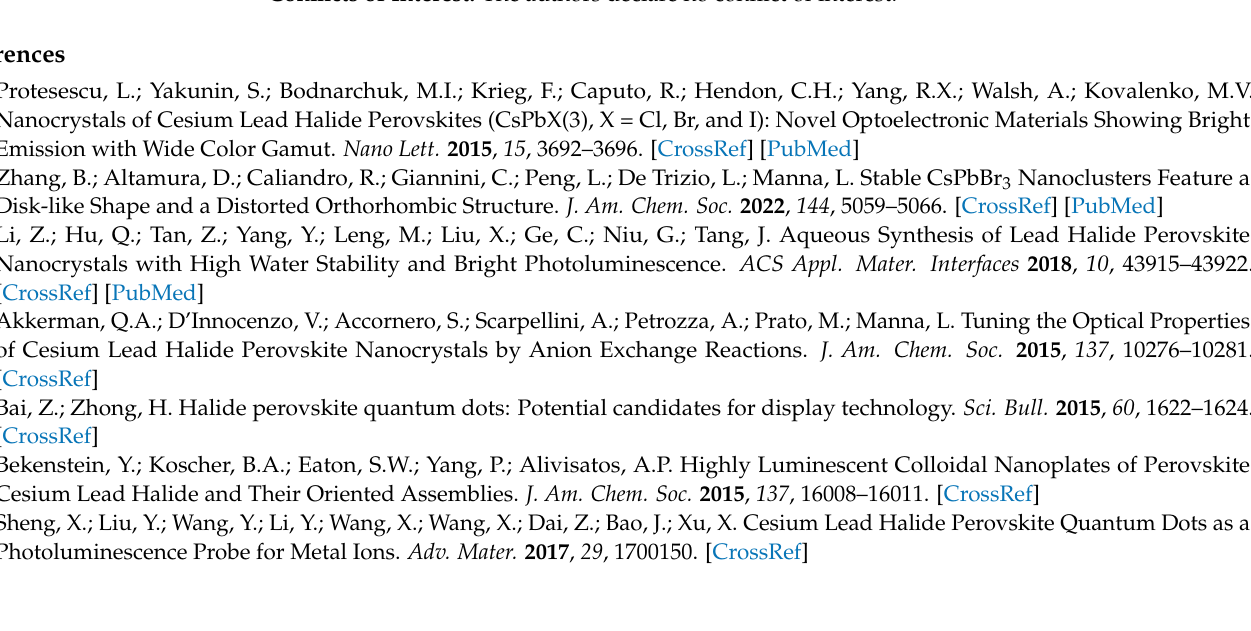
Figure S7: Zeta potential of different molecules and the PNCs (A); Effects of four similar molecules on the fluorescence intensity of the PNCs (B). Experimental conditions: The concentration of the four molecules was 200 µ